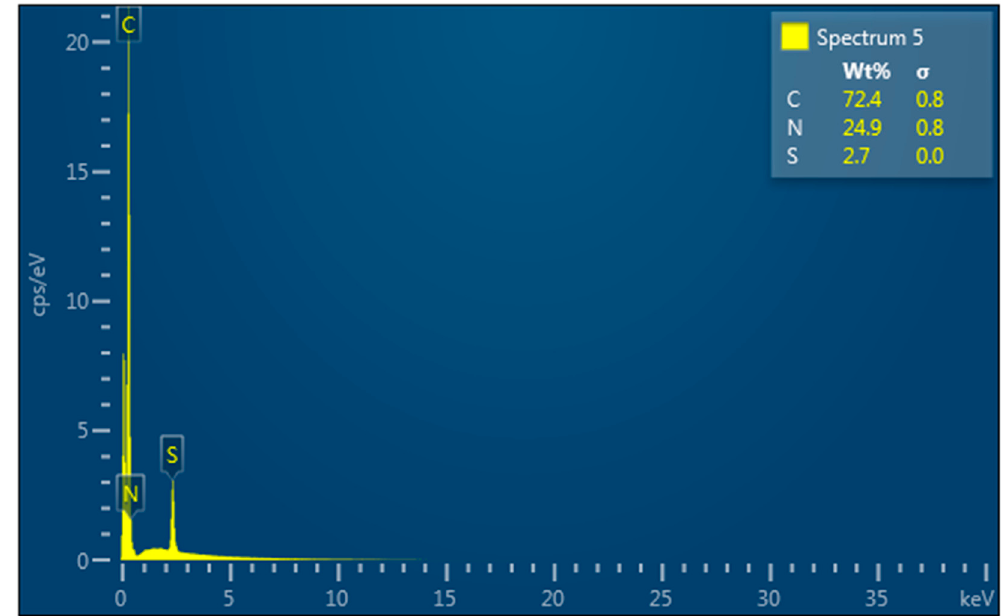
Figure 5. A spectrum revealing the elemental composition of a mesoporous neat PAN monolith obtained using energy- dispersive X-ray spectroscopy (EDS).